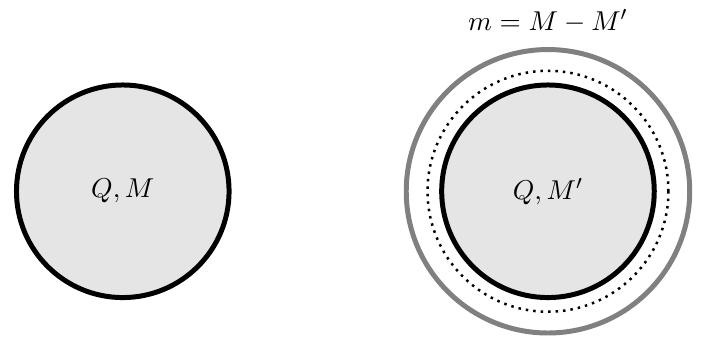
Figure 2 . Cartoon representation of WGC-satisfying corrections to a black hole. On the left we have a black hole with charge Q, and mass M , where M is the ADM mass, in the unperturbed theory. On the right, we add matter to the theory, imagining that it contributes as an uncharged shell (the outer gray ring) with mass m . Keeping the ADM mass fixed, we have m = M − M 0 , where M 0 is the new mass of interior region. The WGC dictates that the singularity remains cloaked in the perturbed solution, so that M 0 ≥ M and m ≤ 0 . The dotted line represents the horizon of the perturbed geometry with m < 0